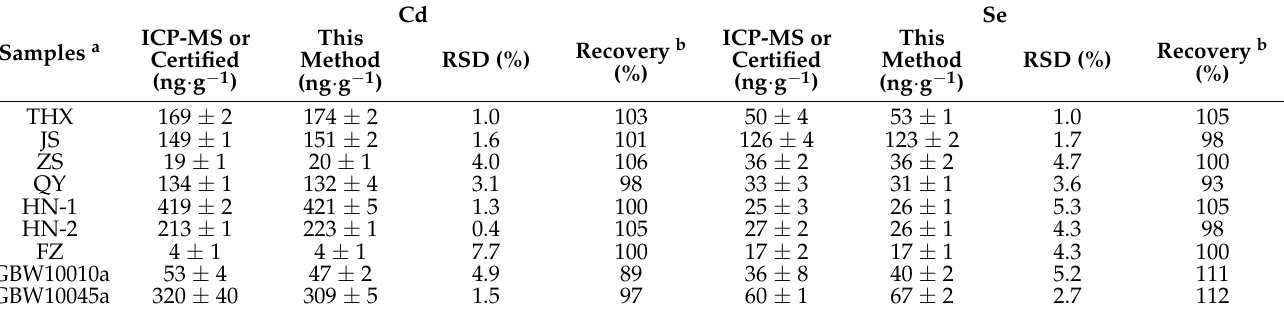
Table 2. Cd and Se presence and recoveries in rice samples ( n =